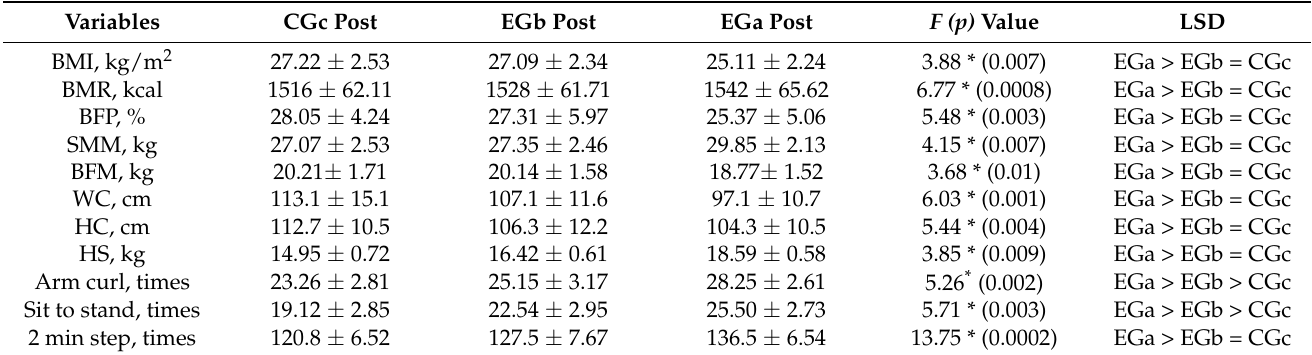
Table 6. One-way ANOVA and LSD of post hoc test and post-test for test items.